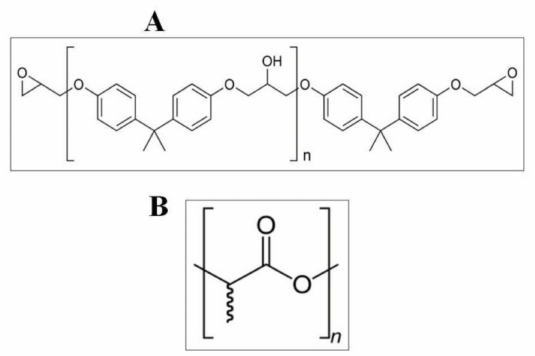
Figure 1. Structure of epoxy resin ( A ) and polylactide ( B ). The admixtures to the composites, added in the amount of 10%, 20%, and 30% by weight, were magnetite (Fe 3 O 4 ), and crystalline cellulose (Avicel PH-1010), as well as starch (a polysaccharide), added in the amount of 10% by weight. Surface morphology studies were conducted by SEM (microstructure studies), using the FEI Quanta 3D FEG-SEM scanning electron microscope, with EDAX Genesis energy dispersion at the magnification of 250, 650, 1000, and 2000 times. The microstructure of samples polymerized in a constant magnetic field (CMF) and without a magnetic field was recorded by means of secondary electrons (Figure 2).